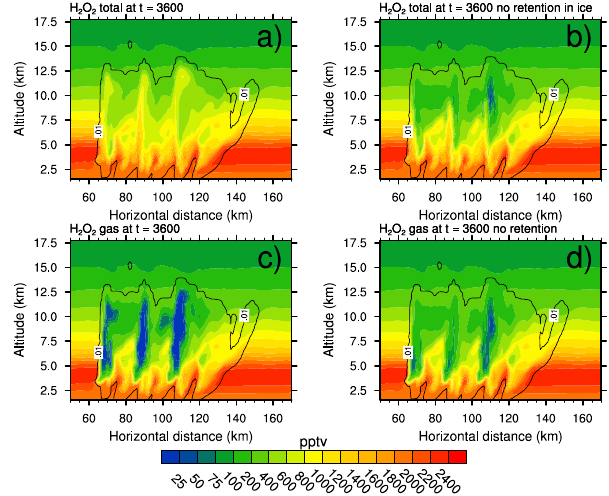
Fig. 13. STERAO case – vertical profiles of gas phase mixing ratio of formaldehyde: black lines are mixing ratio in the convective outflow (135km in horizontal distance in reference to Fig. 12a and b) for simulation with retention in ice (solid line), and for simulation without retention (dotted line). The solid grey line is the mixing ratio for the unperturbed troposphere.